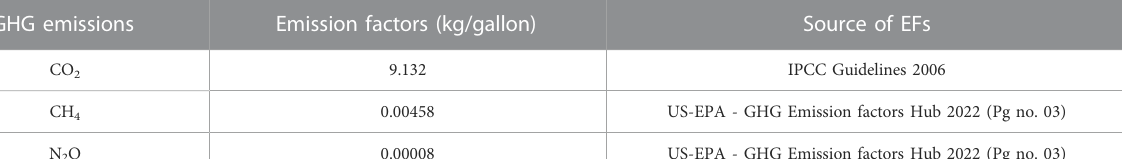
TABLE 4 GHG emission factors (EFs) for gasoline/petrol.